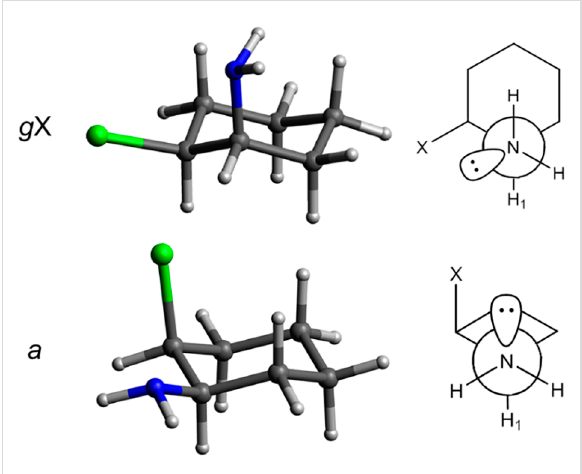
Figure 5: Nitrogen lone pair in rotamers g X ( ae ) and a ( ea ) oriented towards the halogen, making these rotamers less stable in their respective